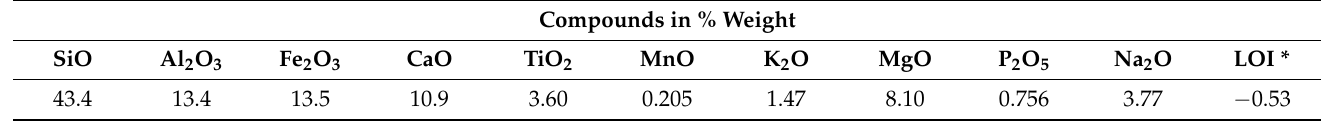
Table 3. Results of chemical analyses obtained by X-ray fluorescence + ICP/AES (Sodium). Compounds in %